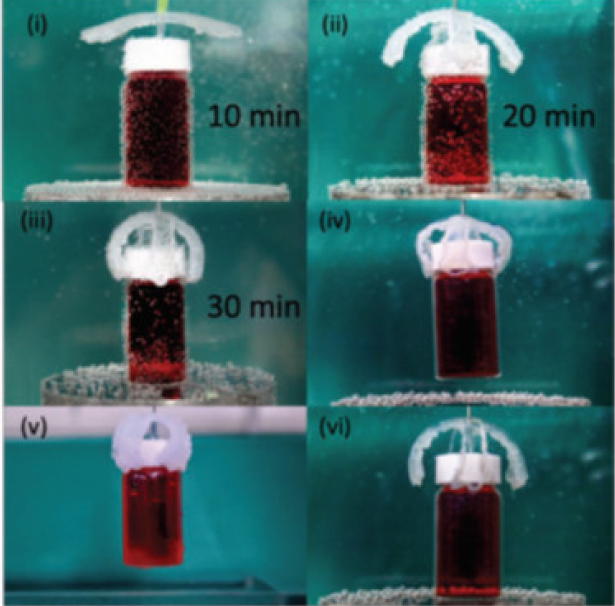
Figure 17. 3D macroscopic gripper at different bending positions; ( i ) before gripping the vial; ( ii ) after gripping the vial; ( iii ) in the gripped state; ( iv ) lifting the vial in water at r.t.; ( v ) lifting the vial in the air at room temperature; and ( vi ) releasing the vial in water at 70 ◦ C. Copyright 2019 John Wiley@Sons. Reprinted with permission from ref.